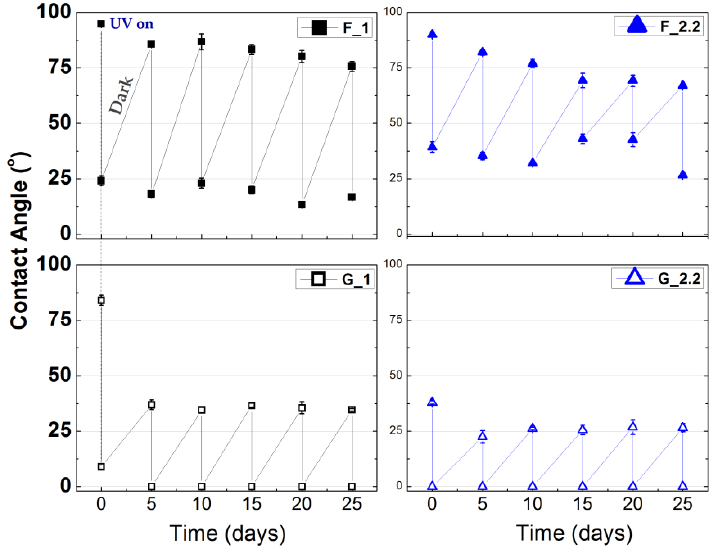
Figure 8. Water contact angle changes of RF-sputtered TiO 2 thin films in five cycles of 30 min UV illumination and consecutive storage in dark and ambient conditions for 5 days.